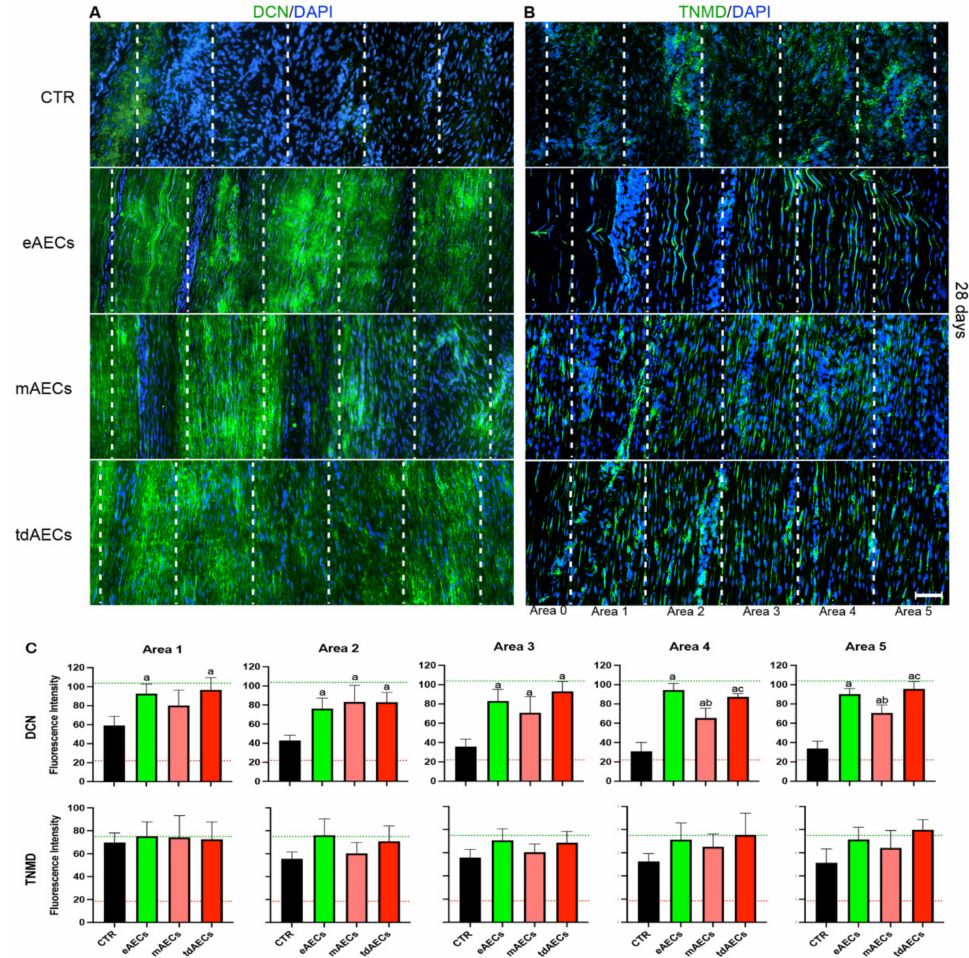
Figure 6. DCN and TNMD expression after eAEC, mAEC, and tdAEC transplantation in injured tendons at day 28 post-surgery. In each panel the healthy portion (area 0 positioned on the left in all images) and the injured area of CTR and treated explants (from area 1 to area 5) are shown with white dashed lines. Representative images of ( A ) DCN and ( B ) TNMD positivity (green fluorescence) detected in the healthy portion of the explants (area 0) and within the injury site of eAEC-, mAEC- , and tdAEC-transplanted tendons. CTR tendons were negative for DCN, whereas TNMD was expressed in the cytoplasm of the cells contained within a disorganized ECM. In treated tendons both molecules at 28 days were expressed in an organized ECM. Nuclei were counterstained with DAPI. Scale bar = 100 µ m. ( C ) Representative histograms of green fluorescence intensities of DCN and TNMD at 28 days CTR (black), eAEC- (green), mAEC- (light red), and tdAEC- treated (red) groups in all analyzed areas using RGB profiler plugin of ImageJ software (NIH). The green and red dashed lines represent the maximum and minimum green fluorescence intensity of DCN and TNMD, respectively. a Statistically significant vs. CTR ( p < 0.05), b statistically significant vs. eAECs ( p < 0.05), c statistically significant vs. mAECs ( p <